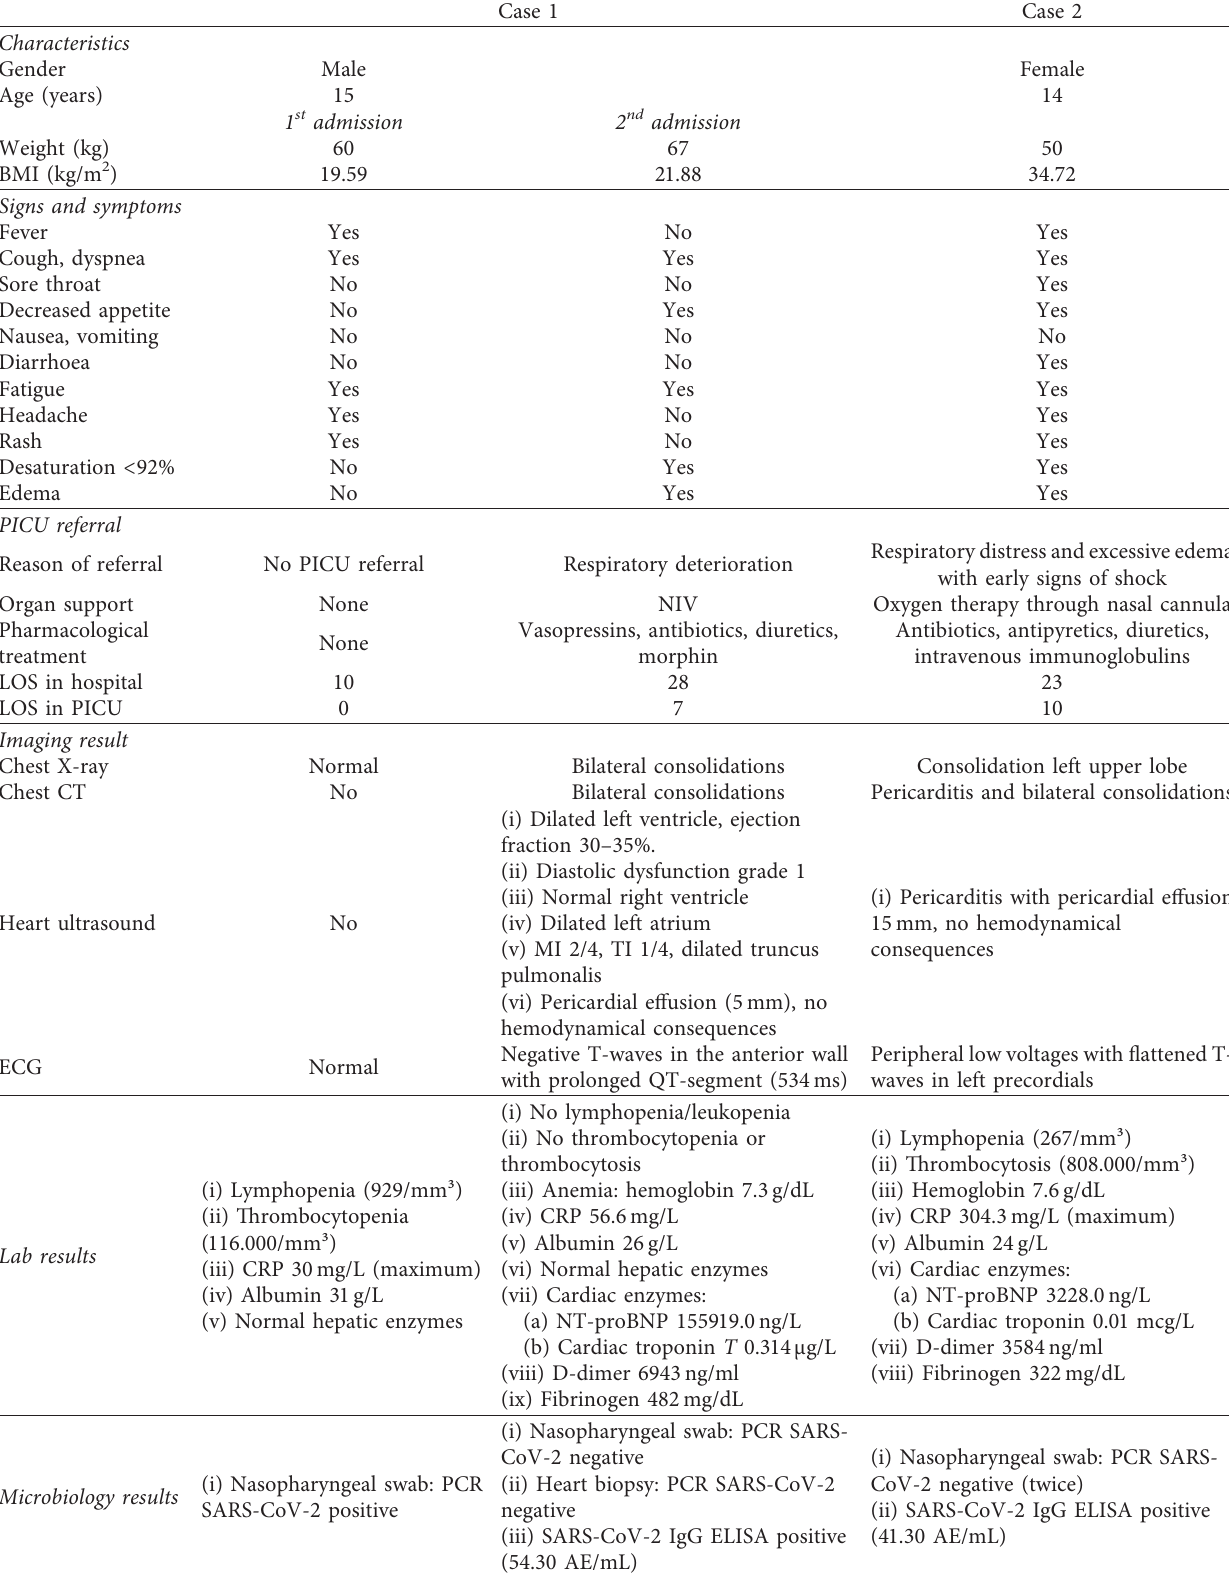
Table 3: Comparing clinical signs and symptoms, lab and imaging, and treatment and outcome for two cases of